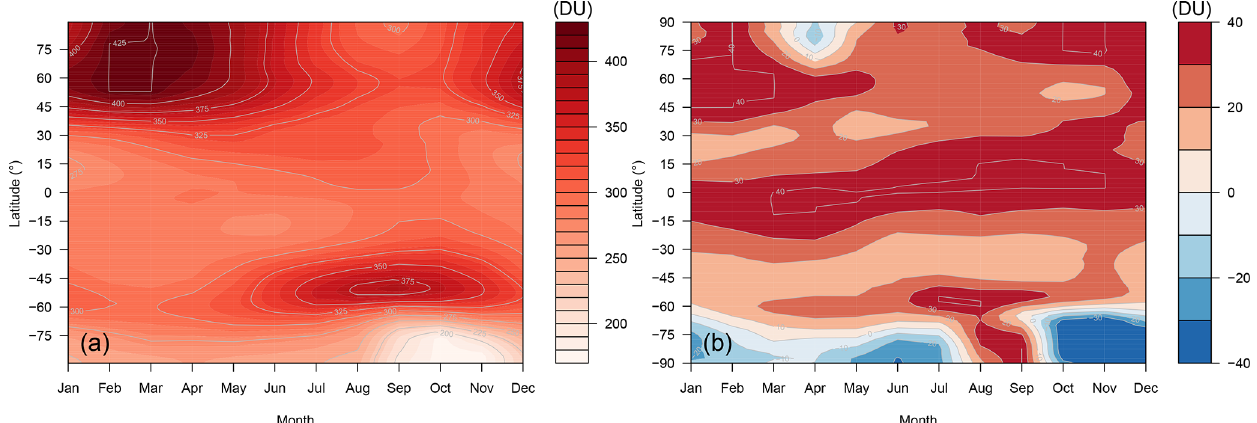
Figure 13. Evaluation of the FR UKCA total ozone climatology. Panel (a) shows the FR simulation multi-annual mean total-column ozone climatology (in Dobson units – DU). Panel (b) shows the difference between the FR ozone climatology and the Bodeker ozone climatology